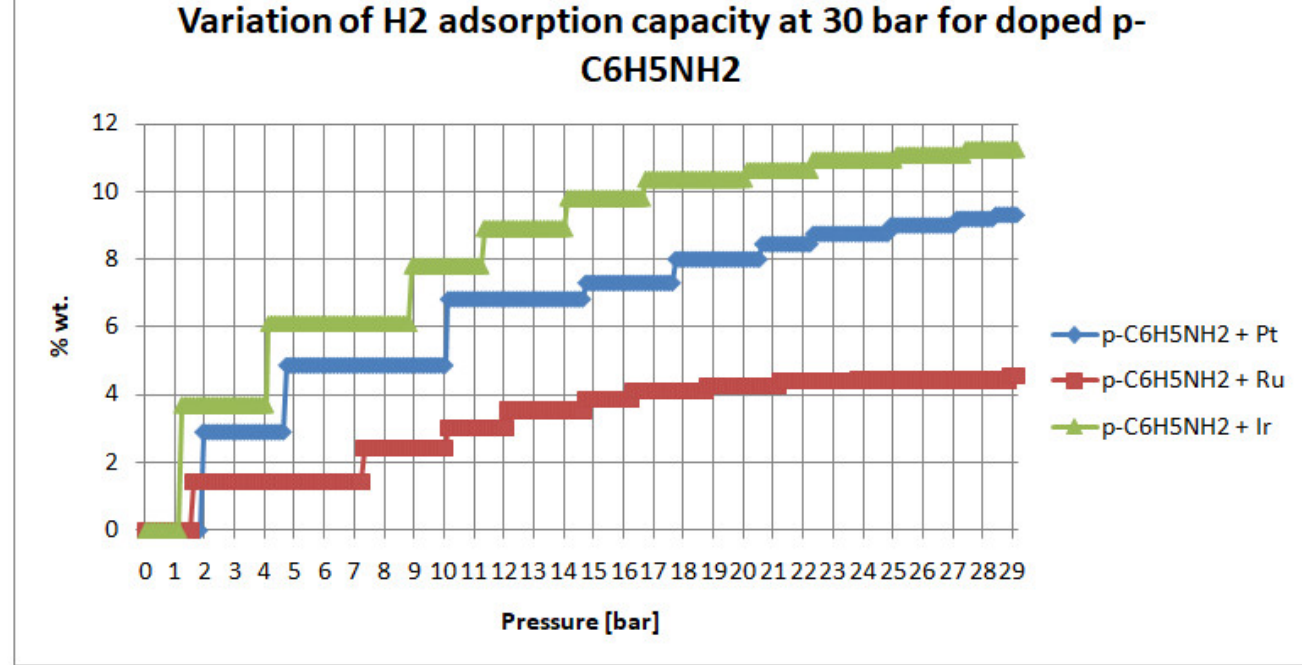
Figure 10. Metal-doped p-C 6 H 5 NH 2 H 2 -adsorption-capacity determination at 30 bar.